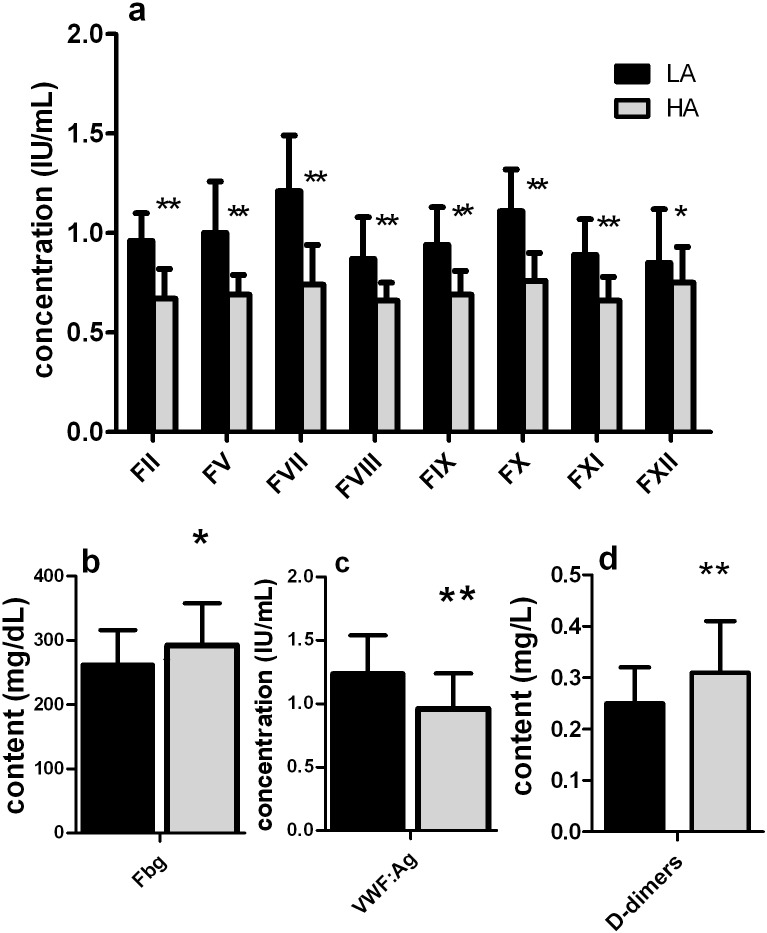
The results coagulation factors of different altitude blood donors.LA, blood donors reside at low altitude (500 m); HA, blood donors reside at high altitude (3,700 m). Values are mean ± SD. LA, n = 46; HA, n = 41. **p<0.001, *p<0.05, when compared LA blood donors and HA blood donors using independent sample Student’s t-tests.